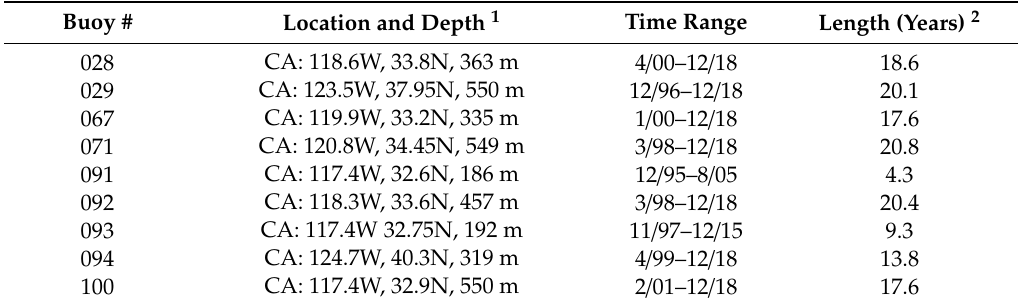
Table A1. Buoy data analyzed for this